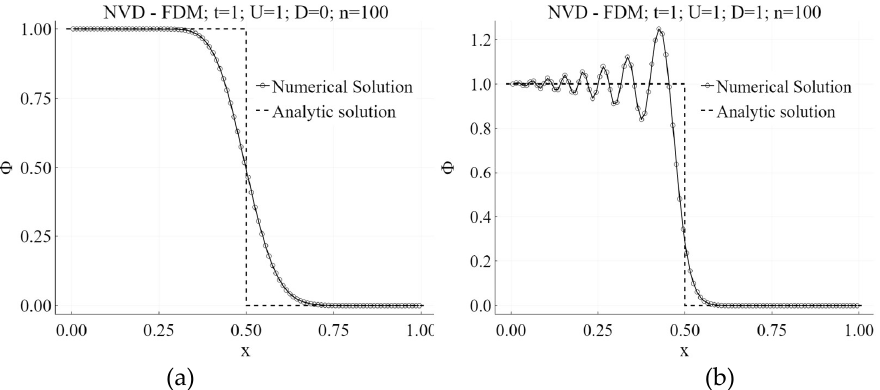
Figure 2. Examples of bad-behaving advection schemes. ( a ): Low order upwind biased scheme causes a lot of numerical diffusion; ( b ): Low order central scheme is being too oscillatory.